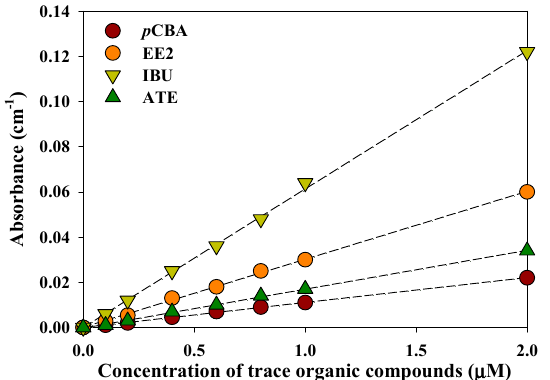
Figure 2. The calibration plots of p CBA, EE2, IBU, and ATE in the range of 0.1 µ M to 2.0 µ M (pH 7, temperature = 20 °C).